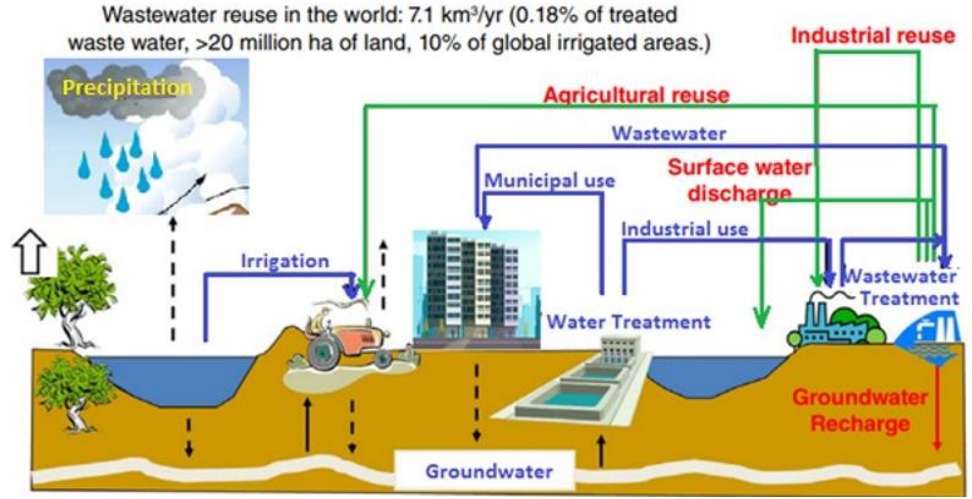
Figure 2. Wastewater reuse and the hydrologic cycle (adapted from [19]).